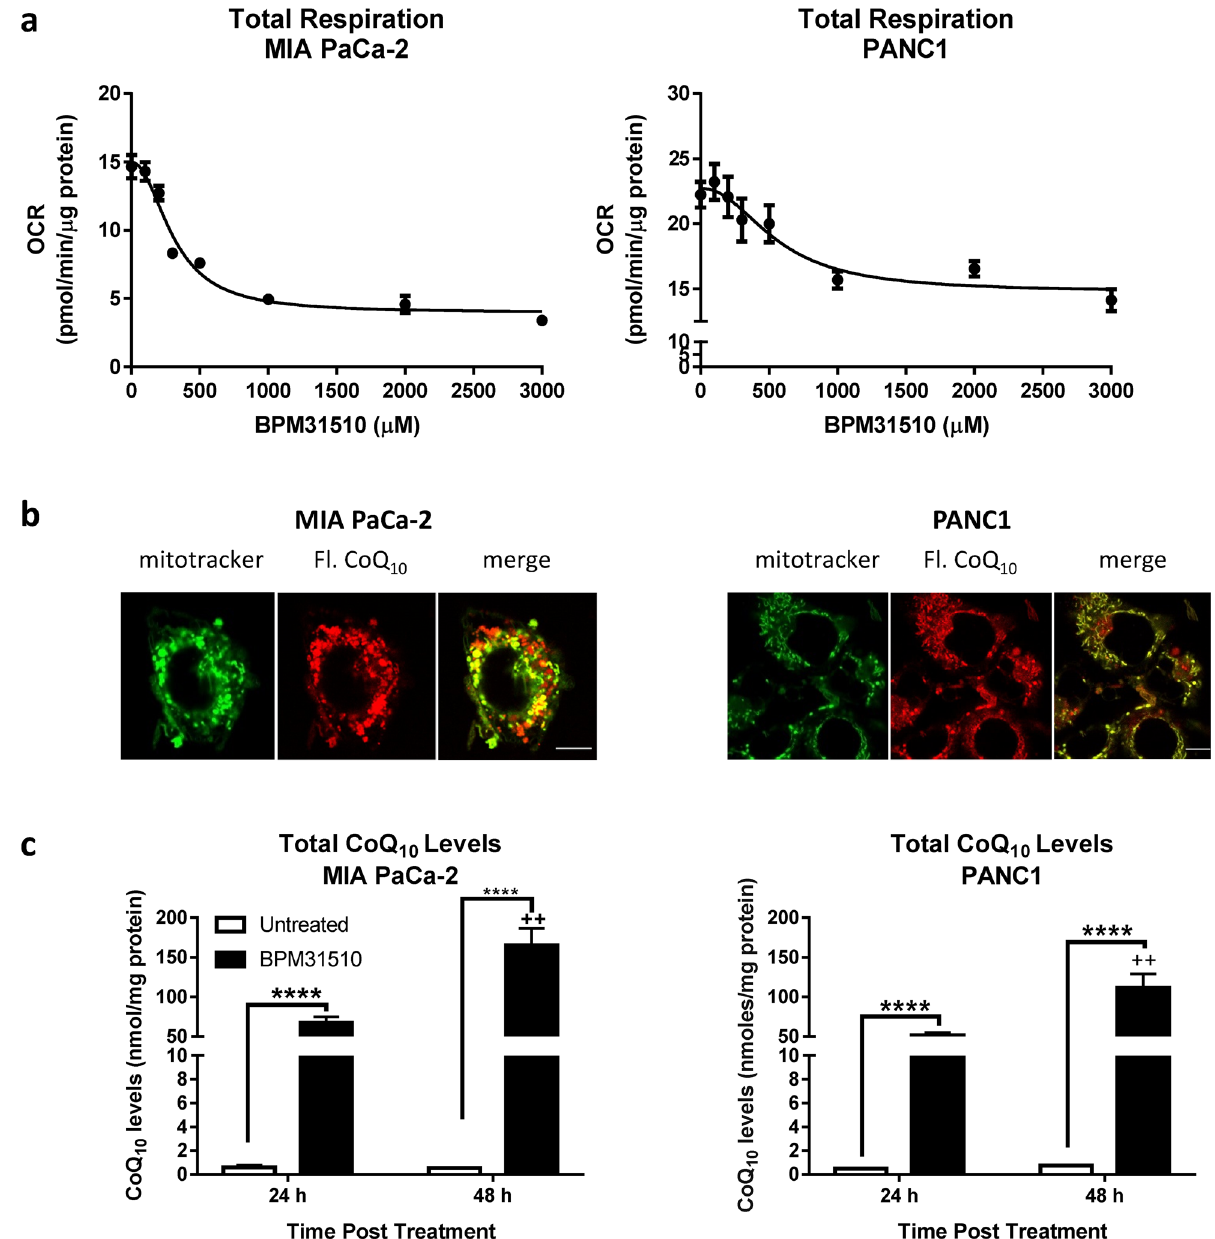
Figure 1. Delivery of CoQ10 into mitochondria by BPM31510 affects total respiration in MIA PaCa-2 and PANC1. ( a ) Dose effect of BPM31510 on total respiration in MIA PaCa-2 and PANC1 cells. State 3 respiration on pyruvate/malate + succinate + glycerol-3-phosphate of cells exposed to BPM31510 at 24 h. The data represent the means ± SEM of three independent experiments with five replicates (n = 15). ( b ) Fluorescently tagged CoQ 10 (red) from BPM31510 (200 μM) colocalized with the mitochondria (MitoTracker; green) in MIA PaCa-2 and PANC1 cells after 24 h exposure. ( c ) BPM31510 treatment increased the total CoQ 10 levels in MIA PaCa-2 and PANC1 cells as measured by LC MS/MS after 24 h and 48 h exposures. The data represent the means + SEM of total protein (nmol/mg) from six independent experiments. The data were analysed by Student’s t tests; ****= p < 0.0001 compared to untreated control; ++ = p < 0.01 compared to the 24 h time point. The scale bar present in each merged image represents 10